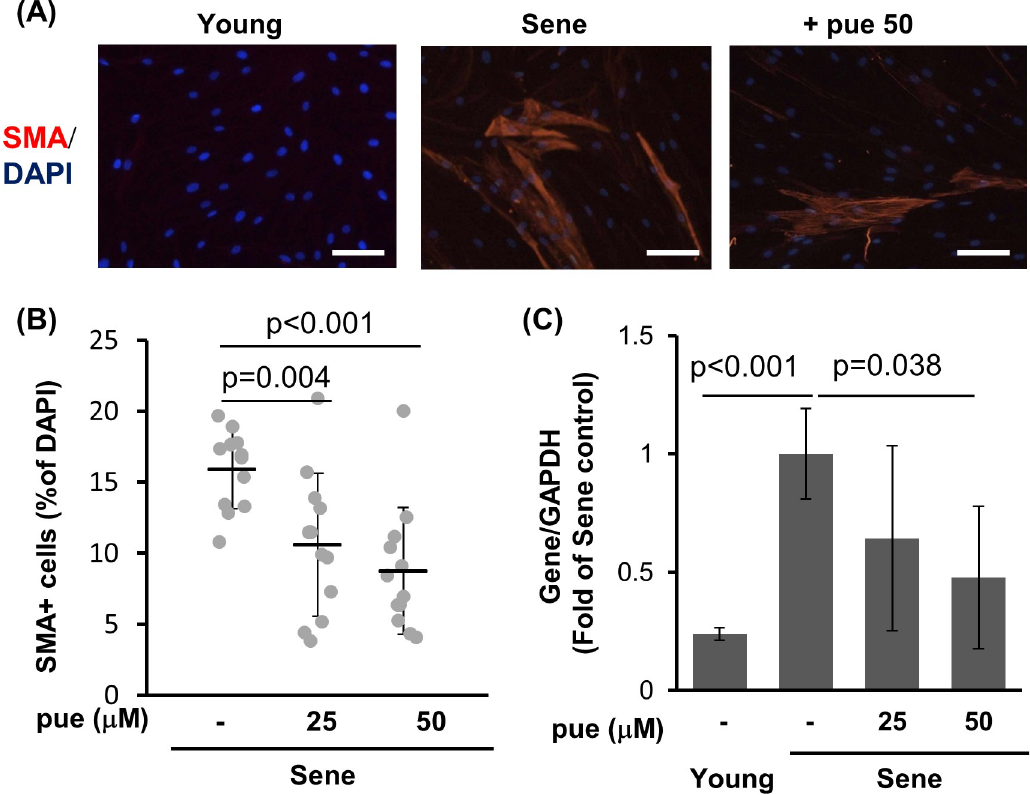
Fig 4. The effect of puerarin on the expression of SMA in high passage NHDFs. A-B: Young or senescent (sene) NHDFs with or without 50 μ M puerarin (+pue 50) were stained for SMA by the immunocytochemical method. The percentage of SMA positive cells per total cells was calculated from 15 microscope fields for each group. Scale bars = 100 μ m. C The expression of SMA mRNA in young and senescent NHDFs treated with or without 25–50 μ M puerarin (pue) for 72 h. n = 4.